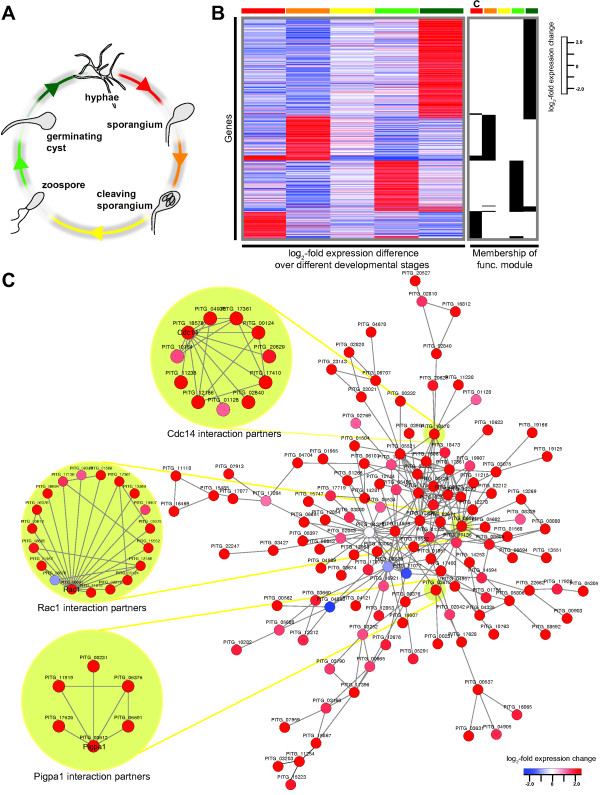
Developmental stages of the asexual lifecycle of P. infestans and determined functional modules. (A) Transition between five distinct developmental stages in the asexual lifecycle of P. infestans. Gene expression data of these stages are available [15] and were used to assess gene expression changes between the transitions. Transitions between different developmental stages are colored coded. (B) The gene expression changes and the membership of all 825 genes predicted in the five functional modules are displayed. The heat map shows the gene expression changes (log2) for the transitions of two subsequent life stages (same color code as in A; heat map saturated at ± 2.5). Presence (black) or absence (white) of genes in a functional module is highlighted next to the heat map and membership is indicated by color code. C refers to the sporulation module as described in (C). (C) Determined functional module of genes up-regulated during sporulation and their predicted associations. Examples discussed within the text and their directly associated proteins are highlighted with light green. The nodes are colored according to the fold change in expression in sporangia compared to hyphae (same scale as in B).